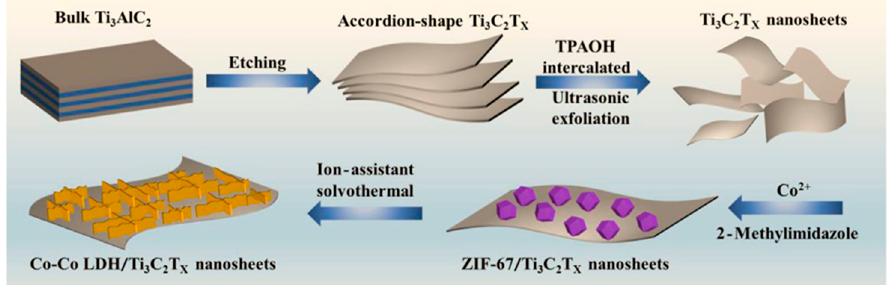
Figure 11. Synthesis scheme of heterostructure Co − Co LDH/TNS nanosheets [113].